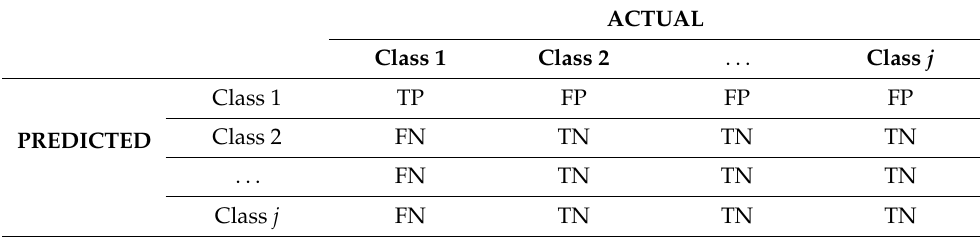
Table 7. Confusion matrix for a j -class classification